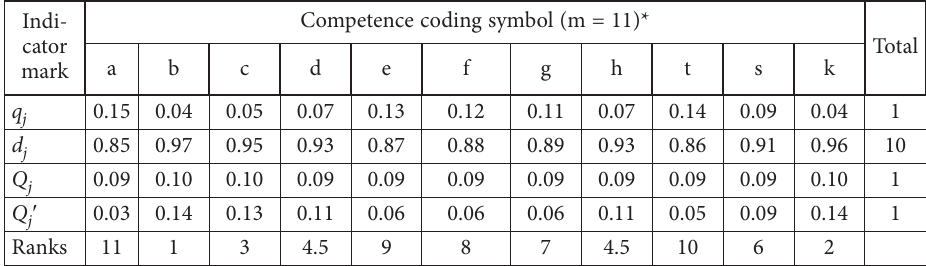
Table 3. The main indicators Q j of the important competencies for logistics managers (compiled by the authors)